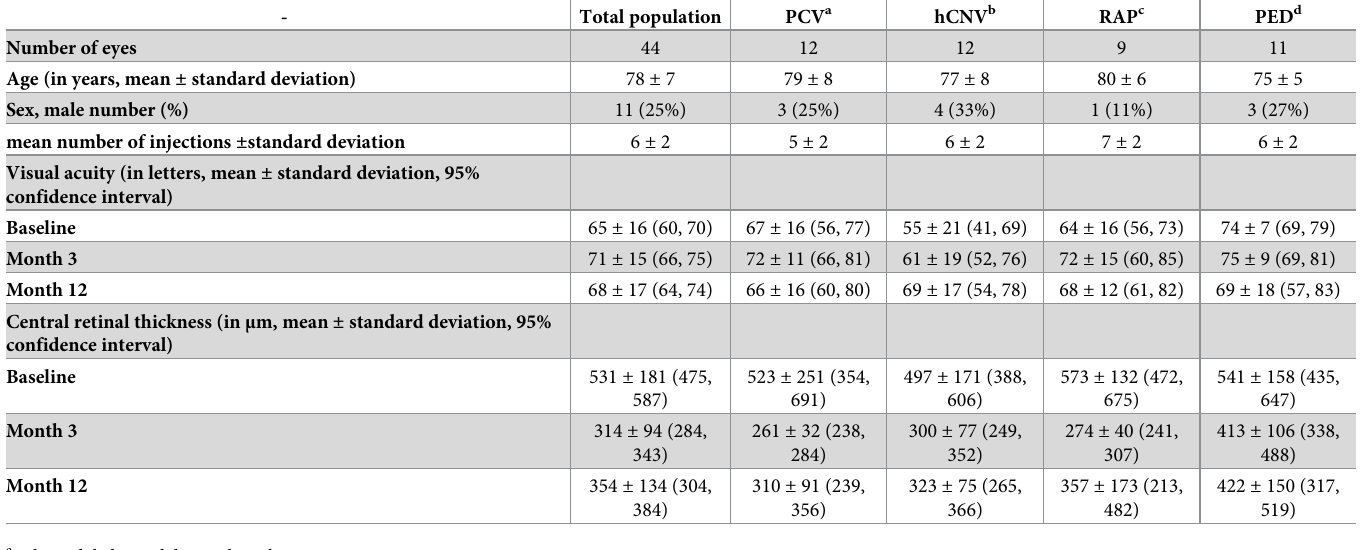
Table 1. Detailed information on the demographic, functional and morphological characteristics at baseline, month 3 and month 12 for the total population and the subgroups.